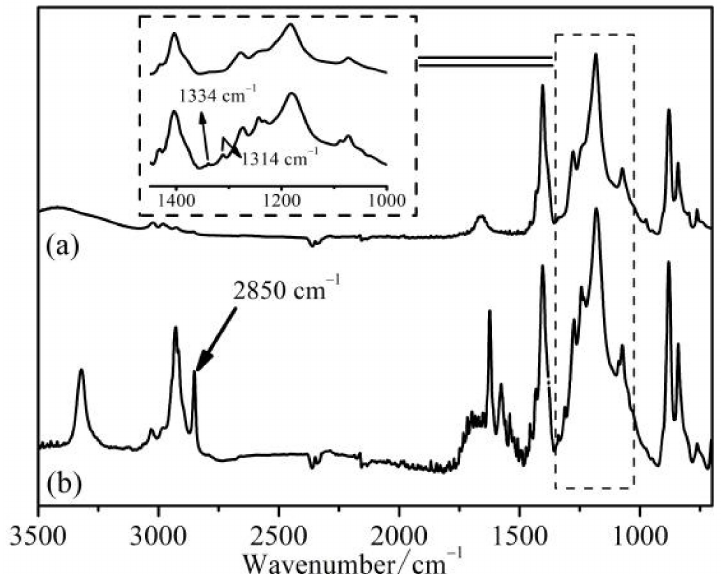
Figure 3. ATR-FTIR spectra of PVDF membrane M0 ( a ), and the modified PVDF membrane M3 ( b ) with the additive of P(St x - co -MAA y )- g -fPEG y at x:y =